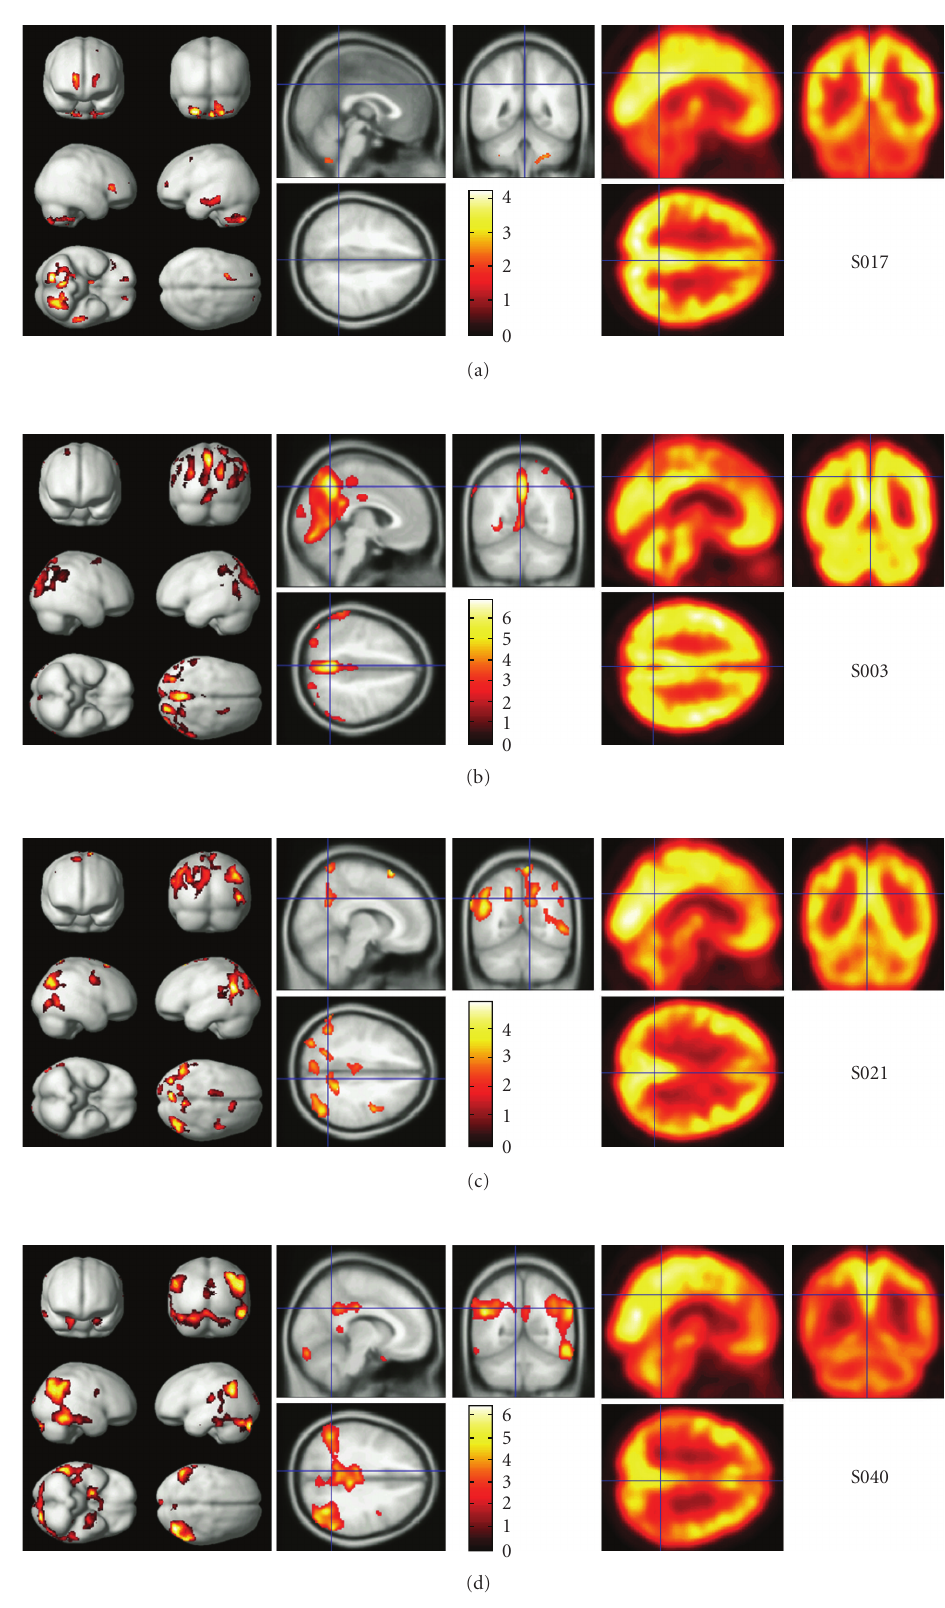
Figure 1: Example results from four subjects in the study. Each row is one subject. The color bar in each row represents the scale for the Z -score in that subject. The left column depicts the SPM Z -map surface rendering, the middle column depicts the SPM Z -map overlaid on a canonical template image in cross section, and the right column shows the FDG-PET scan in